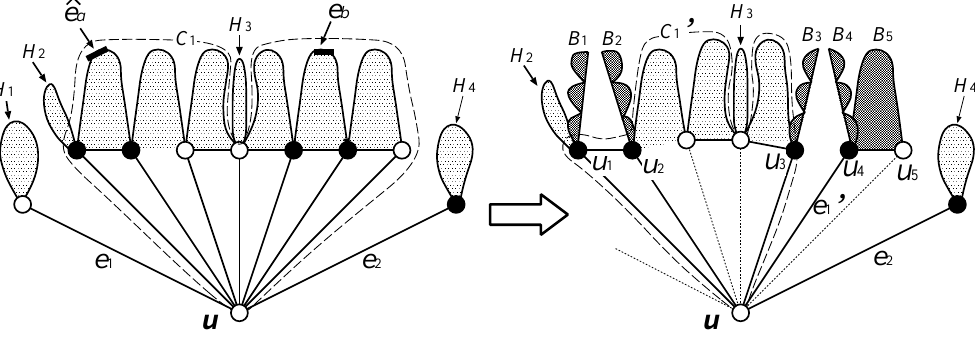
( u ) . Black circles, 1 ( u ) , where block H is 1 1 ; e is a child of e . Edges, e 4 2 a b